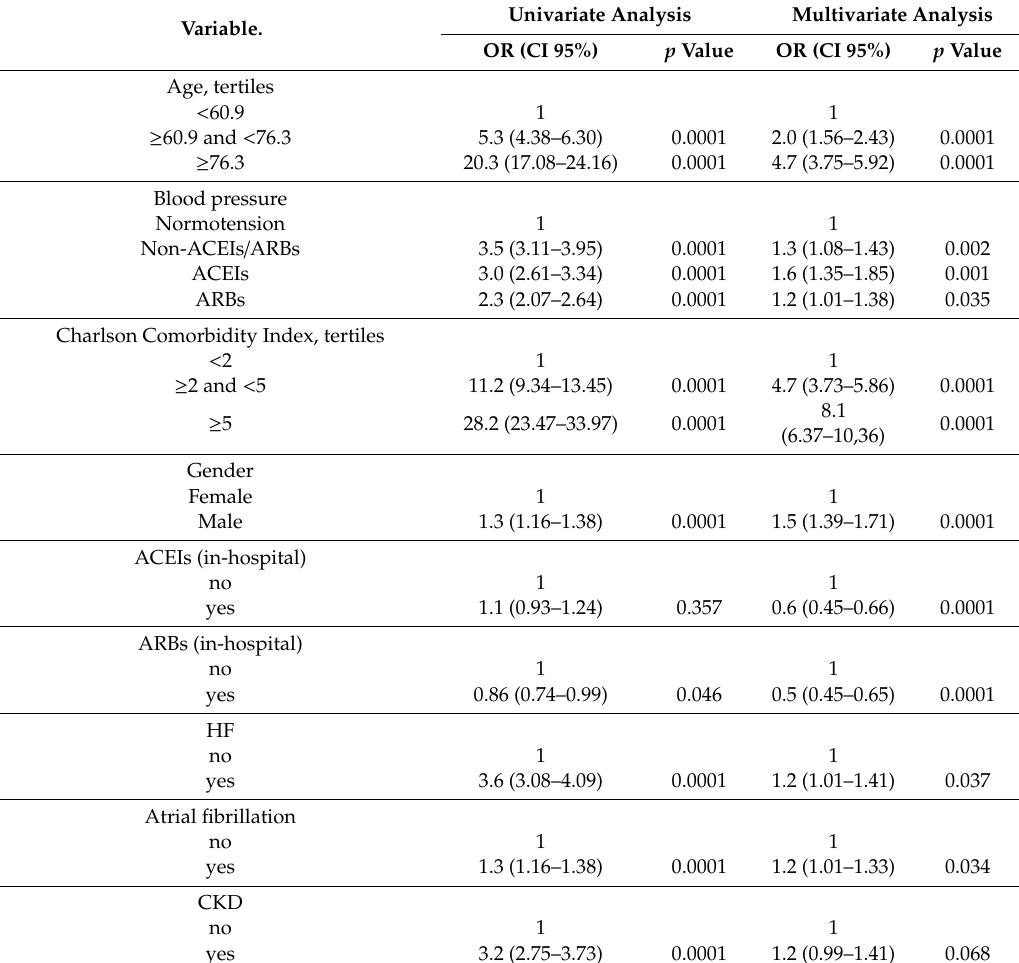
Table 3. Association with in-hospital all-cause mortality. Univariate analysis and adjusted multivariate logistic regression model. CKD: chronic kidney disease; HF: heart failure.